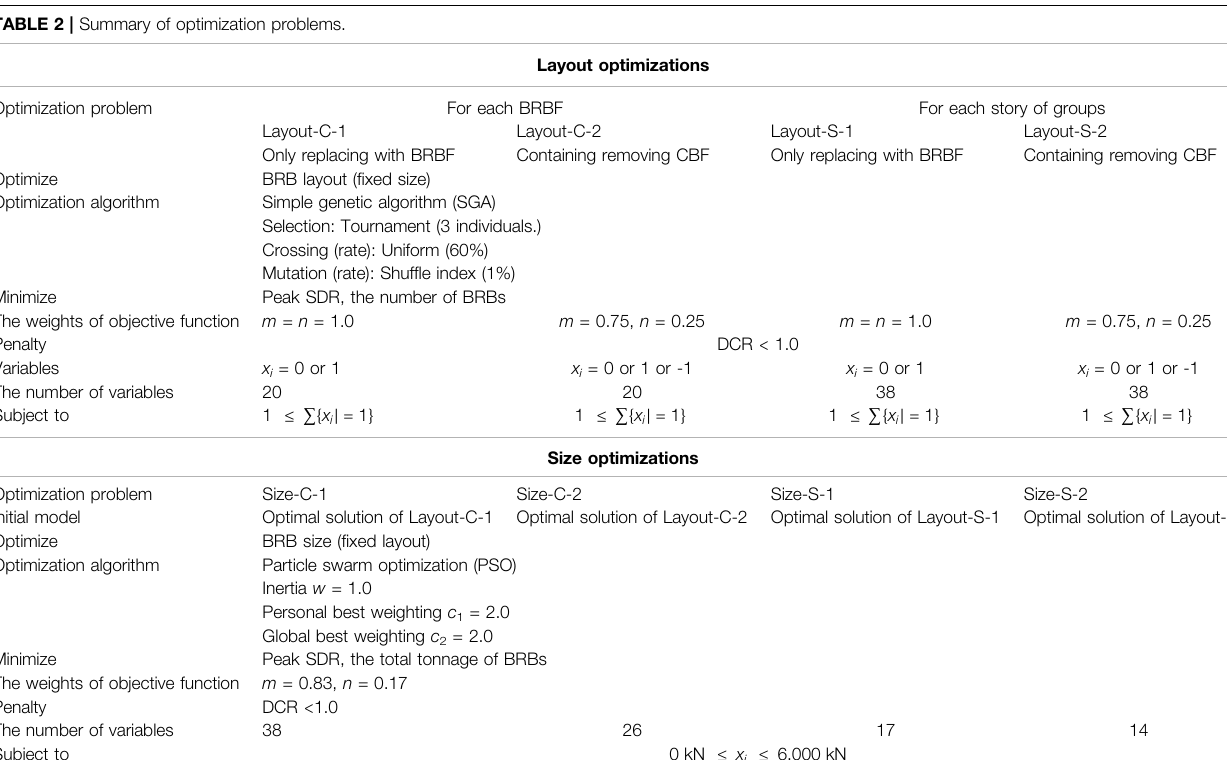
TABLE 2 | Summary of optimization problems.